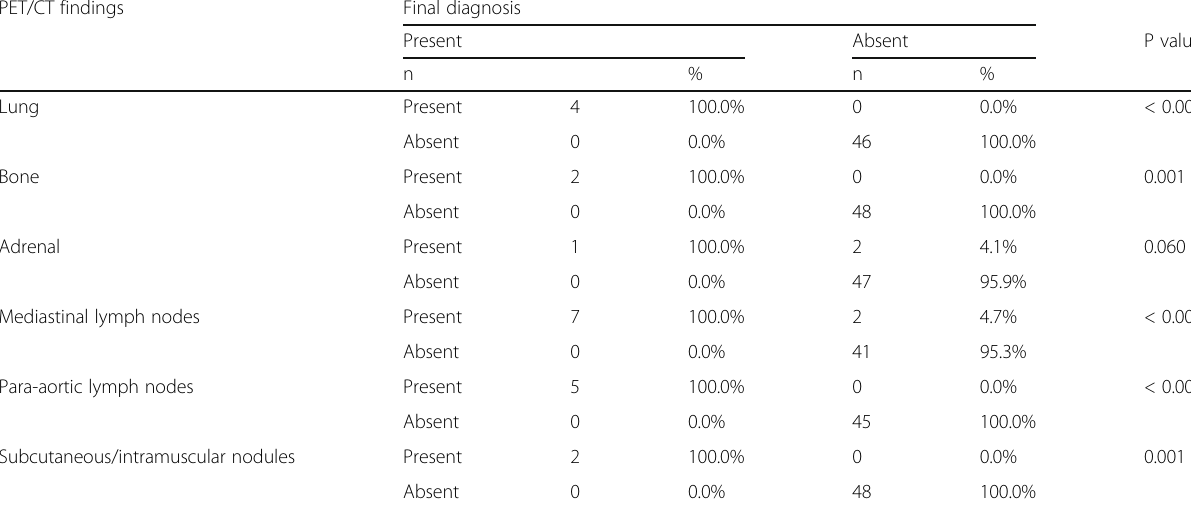
Table 4 Comparison between PET/CT findings and final diagnosis in the distant metastatic subgroups PET/CT